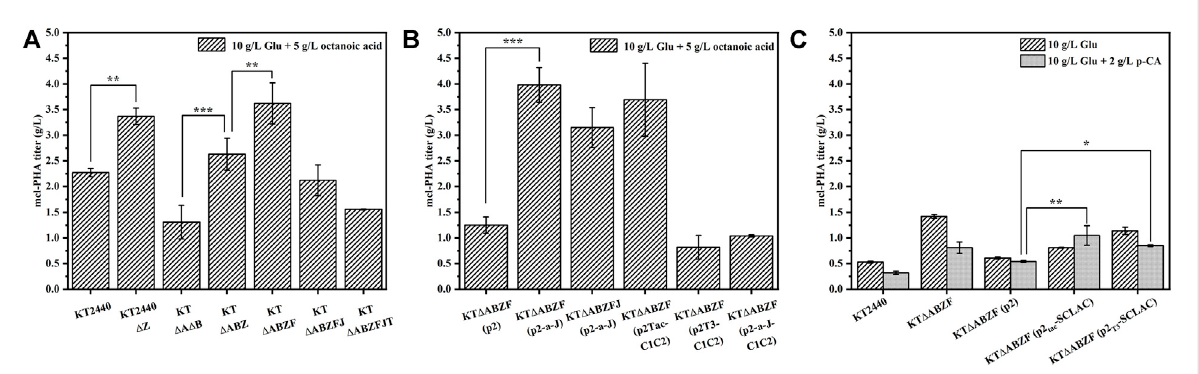
FIGURE 2 The ability of the engineered P. putida by genetic modi fi cations to produce mcl-PHA. (A) The engineered P. putida by knocking out corresponding genes. (B) The engineered P. putida by overexpression corresponding genes. (C) The engineered P. putida by heterologous expression of laccase. The error bars indicate the standard deviation of triplicate experiments. * p < 0.05; ** p < 0.01; *** p <